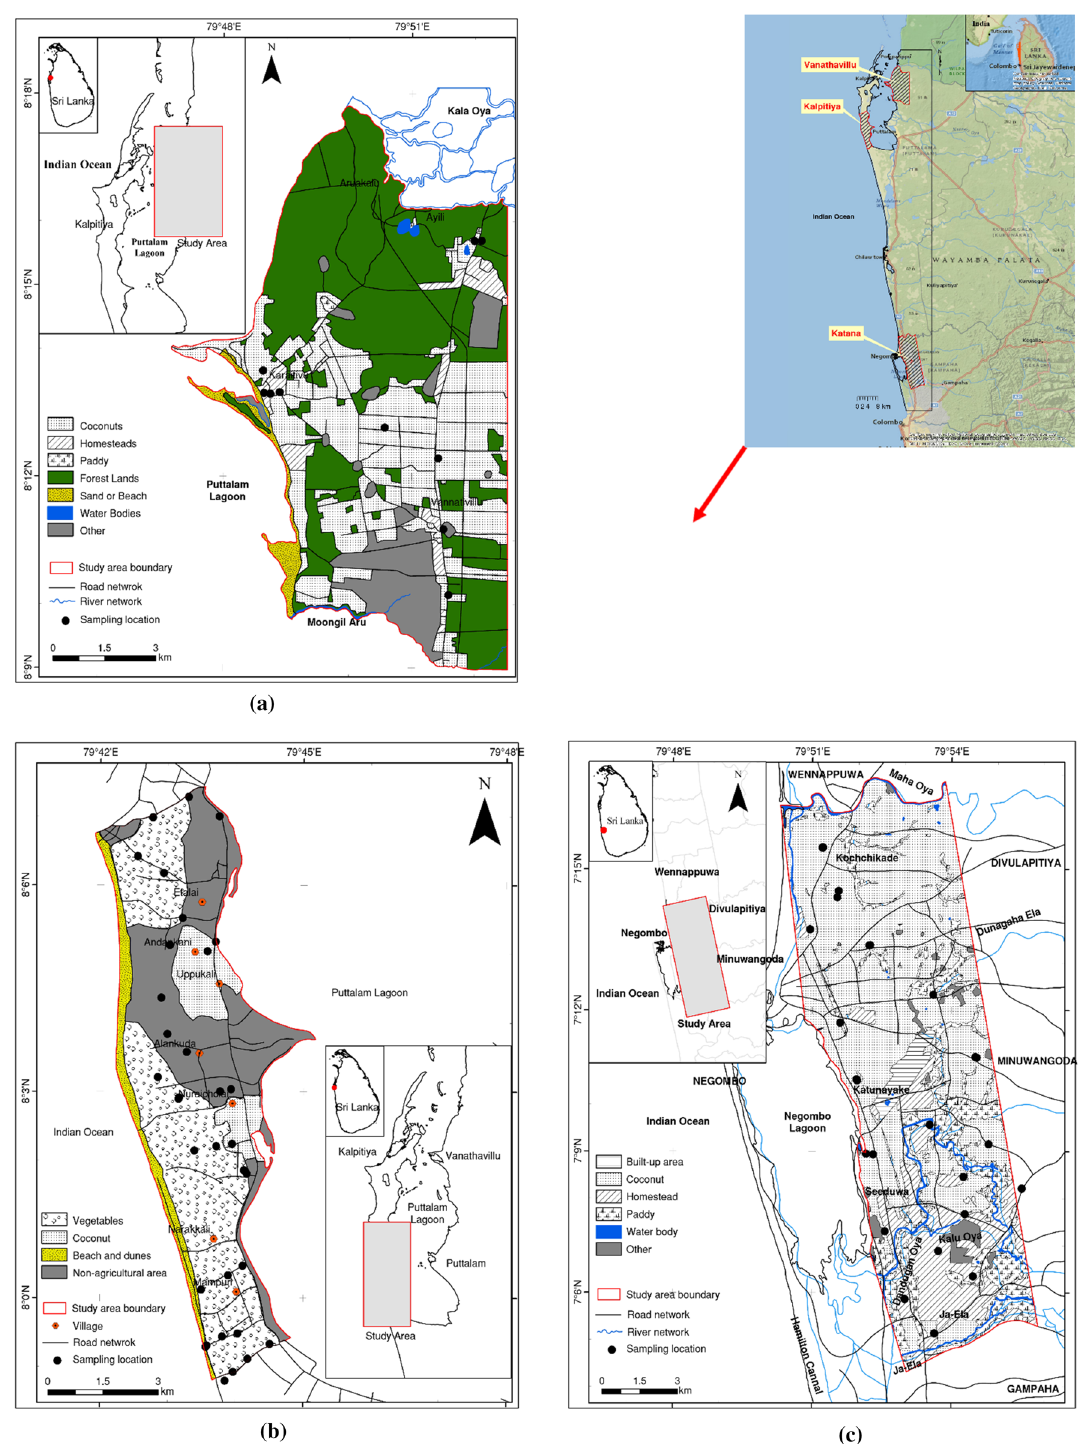
Fig. 1 Location of a Vanathavillu, b the Kalpitiya, and c the